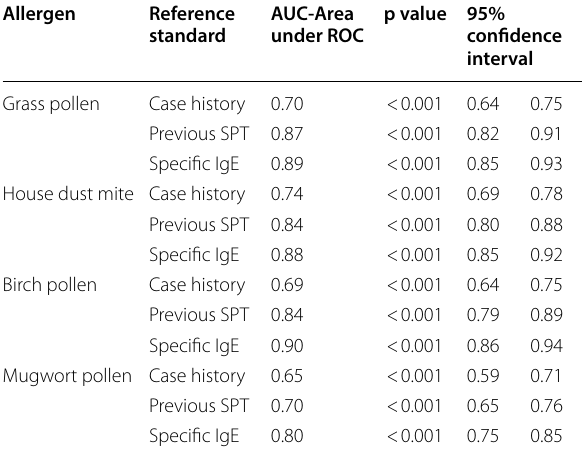
areas under ROC